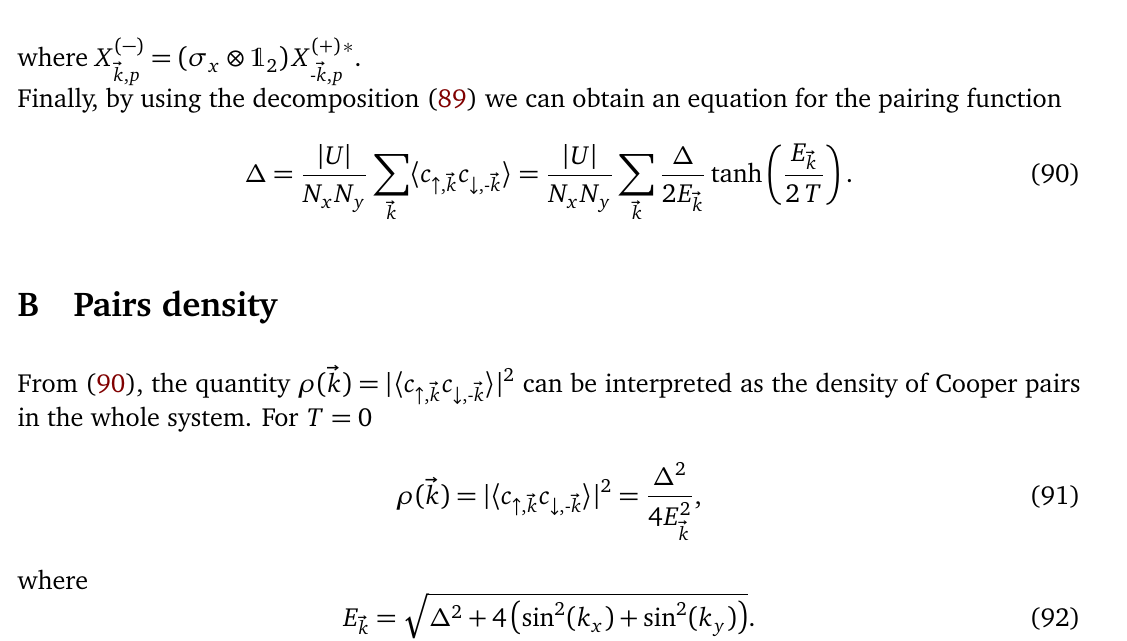
Figure 8: (color online) The plot of Cooper pairs density ρ ( k (91). Up to ∆ ≈ 1, with good approximation the Cooper pairs are formed around Dirac cones